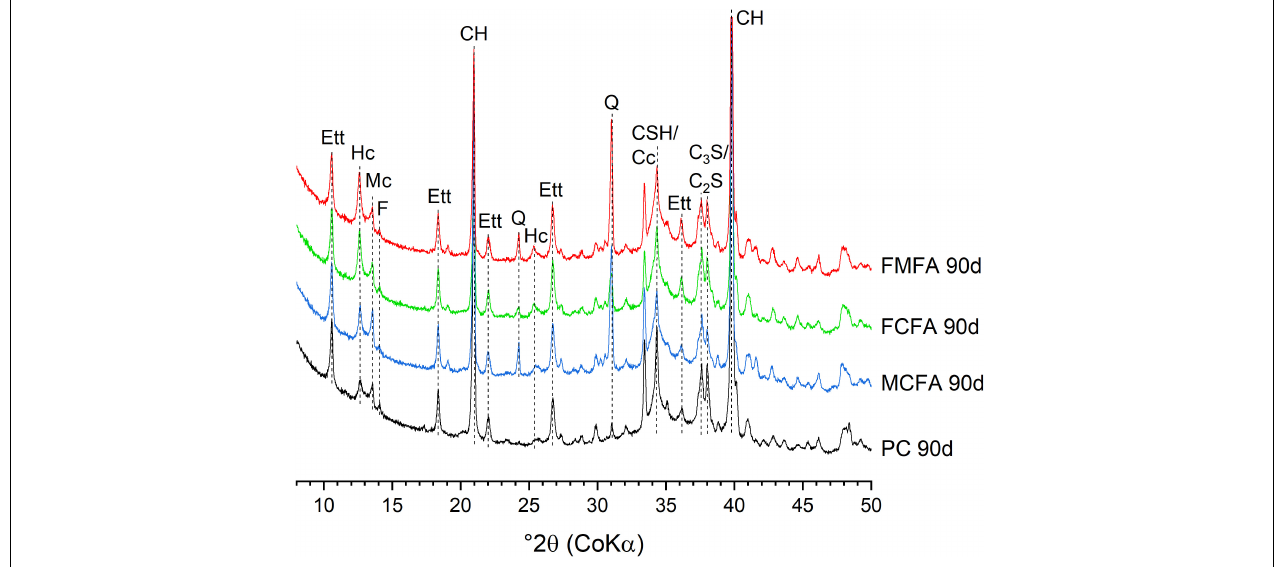
FIGURE 7 | XRD scans of 90 days hydrated fly ash blended cements and reference Portland cement. The main XRD reflections are assigned to the corresponding phases: Ett, ettringite; Hc, hemicarboaluminate; Mc, monocarboaluminate; F, ferrite (C 4 AF); CH, portlandite; Q, quartz; CSH, C-S-H; Cc, calcite; C 3 S, alite; and C 2 S,